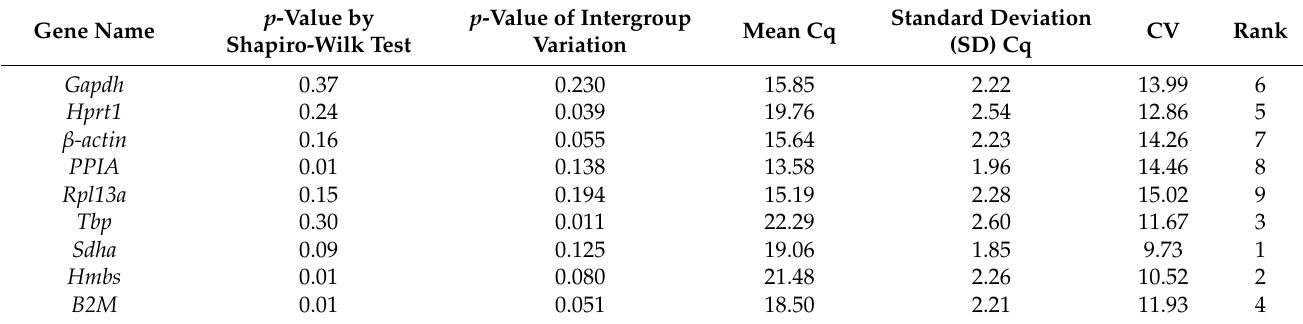
Table 3. Expression features in different tissues at postnatal day (PND) 4W under the natural photoperiod condition analyzed by SPSS.